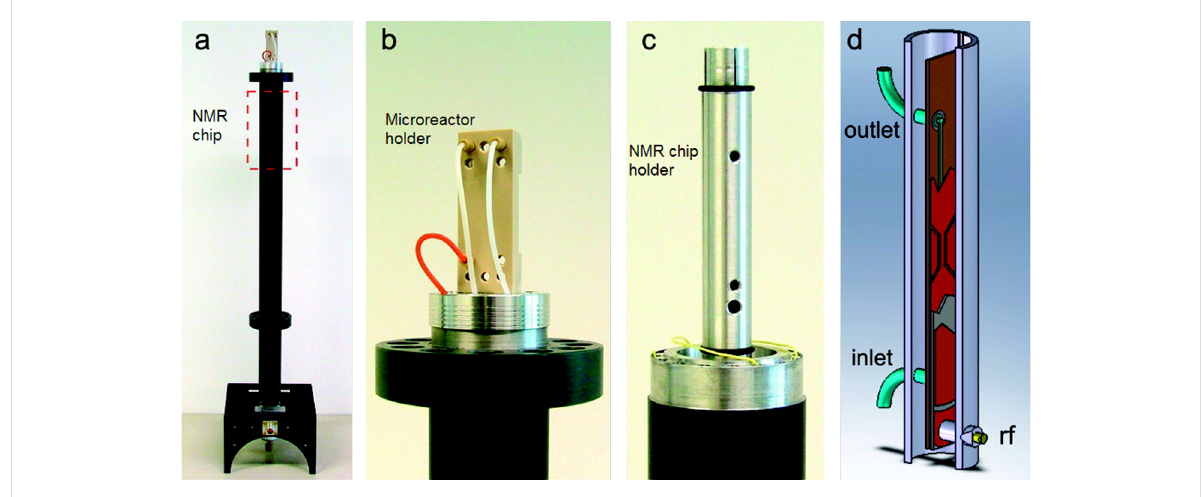
Figure 6: (a) Microfluidic probe. (b) Microreactor holder. (c) Stripline NMR chip holder. (d) Arrangement of the microfluidic chip in the holder. Repro- duced with permission from reference [44]. Copyright 2009 The American Chemical